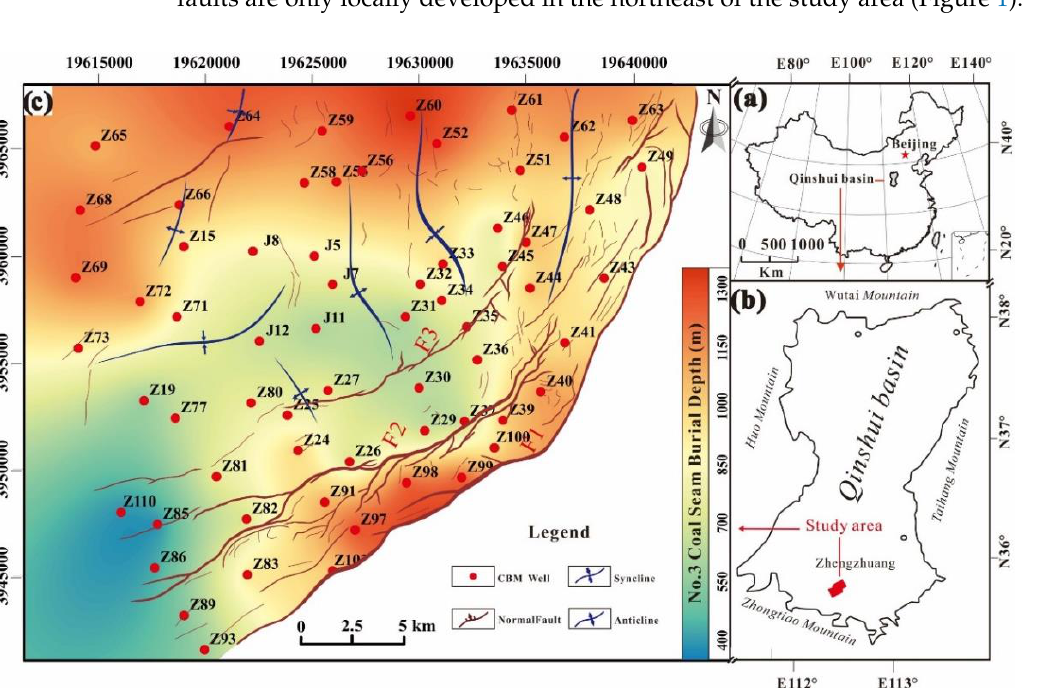
Figure 1. Map showing the location and geological structures of the Zhengzhuang field in the southern Qinshui Basin, North China. ( a ) Location of Qinshui Basin in China. ( b ) Location of the Zhengzhuang field in Qinshui Basin. ( c ) Structure of the Zhengzhuang field. F1 = Sitou fault; F2 = Houchengyao fault; F3 = Zhengzhong fault.